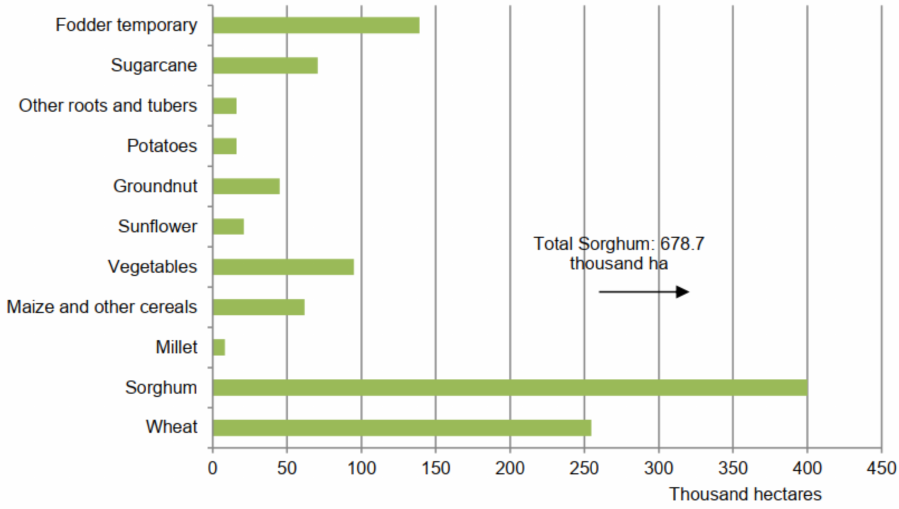
Figure 11. Main irrigated crops in Sudan